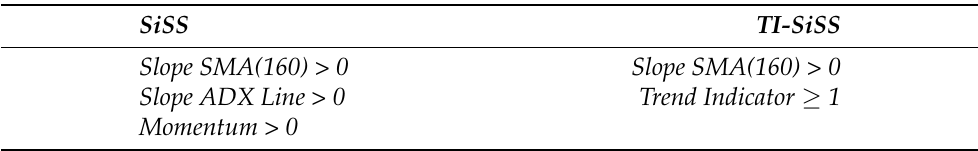
Table 4. Filtering component for both TI-SiSS and SiSS